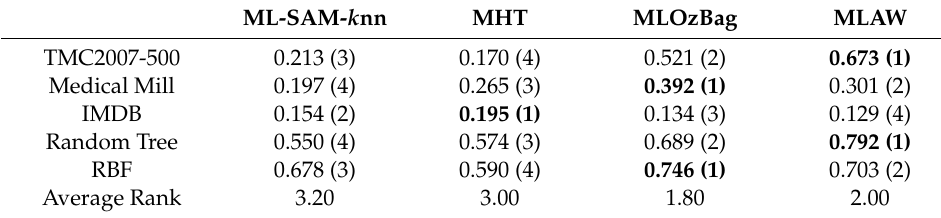
Table 5. Subset accuracy of di ff erent algorithms.